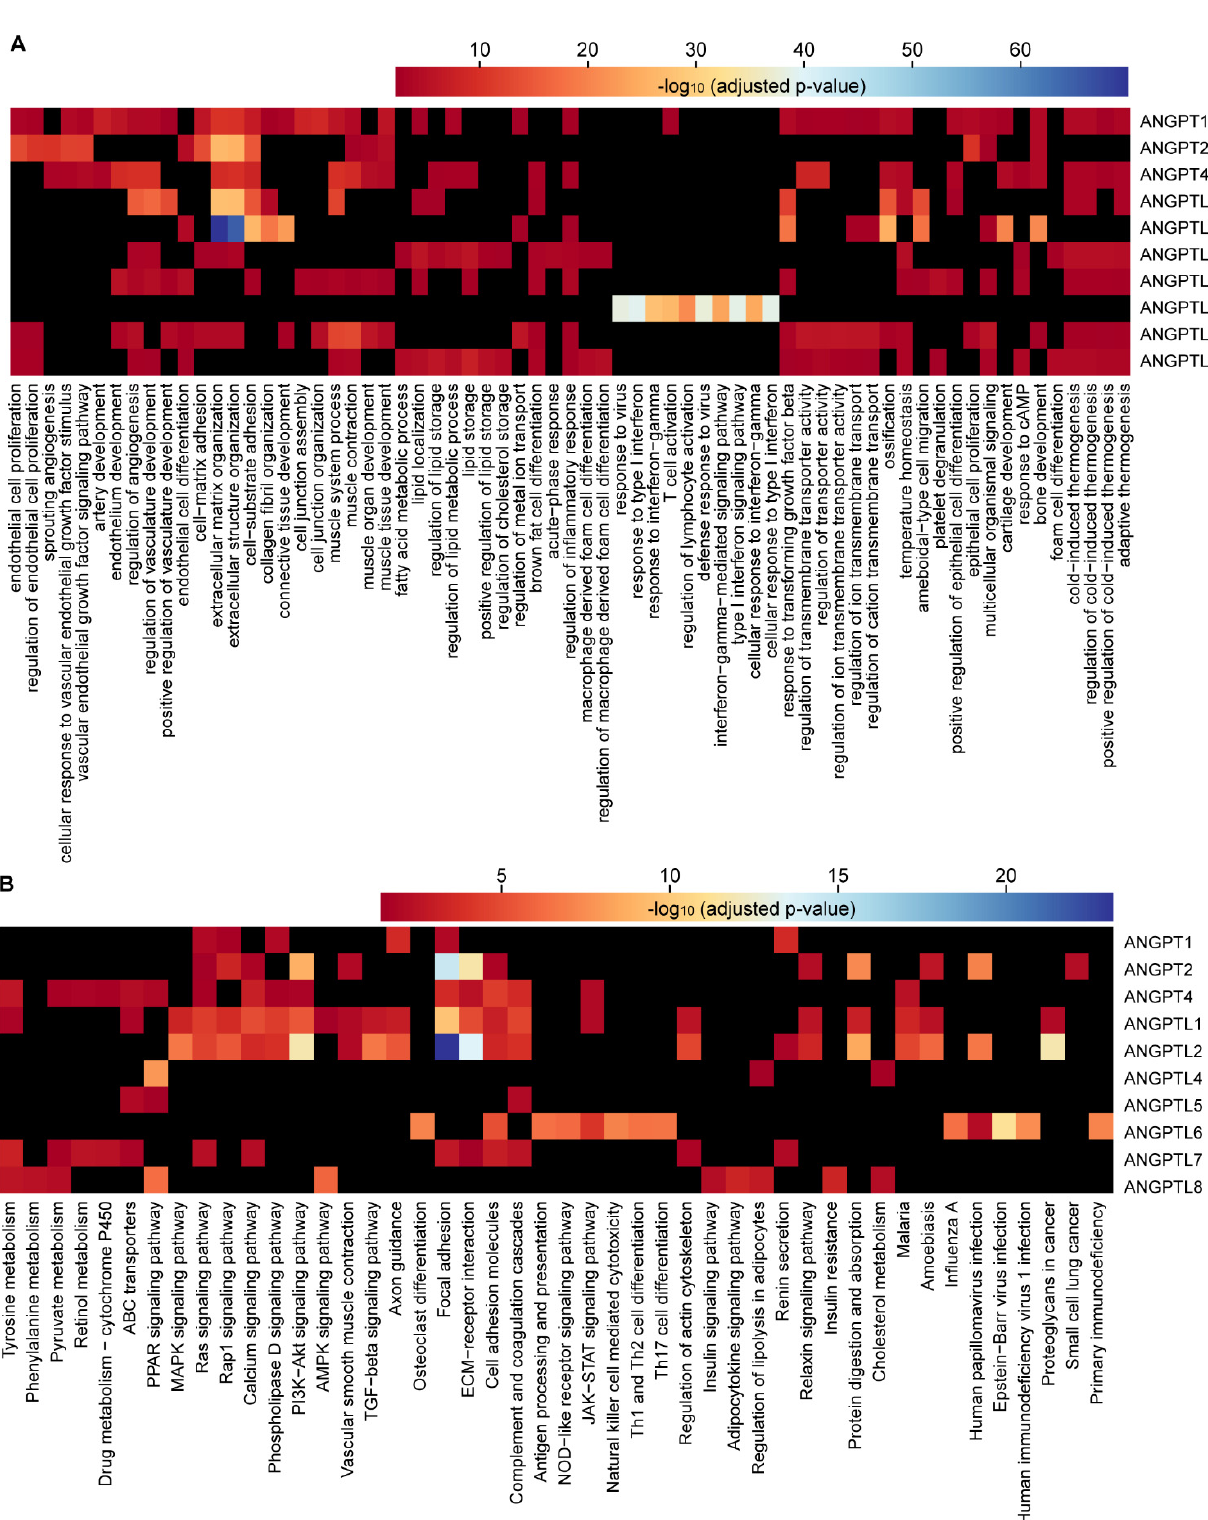
Figure 8. Elucidation of biological functions for ANGPT/ANGPTL genes using gene co-expression networks. ( A ) Heatmap presentation of top ten biological processes identified by GO functional enrichment analysis of the genes positively co- expressed with ANGPT/ANGPTL genes. ( B ) Heatmap presentation of top ten pathways identified by KEGG analysis of the genes positively co-expressed with ANGPT/ANGPTL genes. The cutoff for significance is adjusted p < 0.05. Black squares indicate no significance.